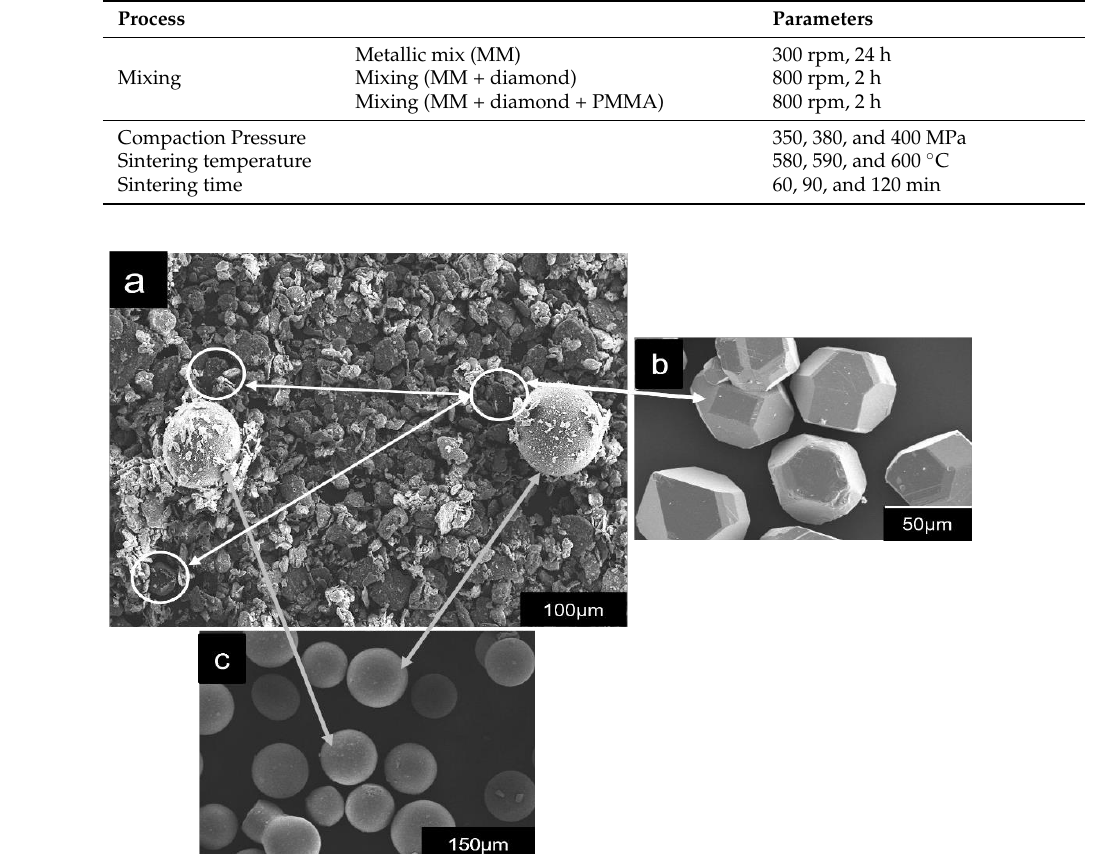
Table 2. Powder metallurgy processing parameters.